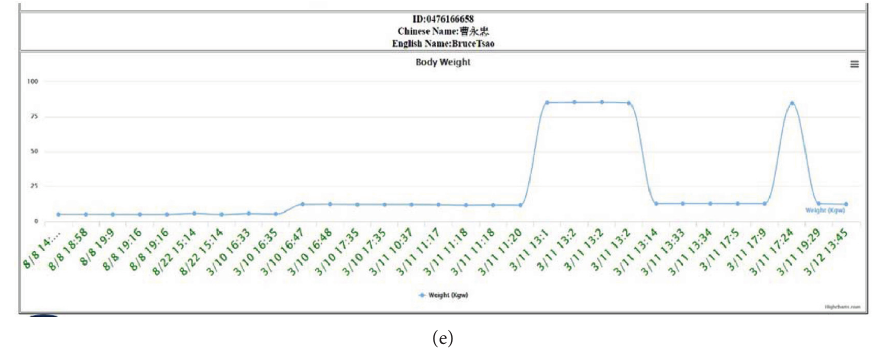
Figure 6: Detailed data displayed after clicking on the icon are shown in Figure 5 and presented as charts. These detailed charts are generated from the cloud platform provided by the SHMS. (a) shows the blood pressure results, including the blood pressure itself (systolic blood pressure and diastolic blood pressure) and the heart rate (maximum of 120 records), produced by our blood pressure device. Clients can learn the circulation status of the whole body, whether their blood pressure status is good or poor, and when hypertension occurs. (b) shows the blood oxygen results, including the blood oxygen level and heart rate (maximum of 120 records), obtained with the blood oxygen device. These results help clients understand the final blood circulation status and the circulation status of the whole body, which indicates whether their blood circulation is good or poor. (c) shows the head temperature results from thermal temperature scans (maximum of 120 records), which can be employed to detect and record body temperature in a contactless way. (d) shows the body temperature results from the elbow (maximum of 120 records) produced by our body temperature device. This device can continue to detect and record body temperature at intervals of a few seconds; thus, it can be applied in unhealthy conditions and can provide data that can be displayed in a long-term continuous temperature chart for the same interval. (e) shows the user weight results (maximum of 120 records) produced by our body weight device, and clients can determine whether they need to improve their health based on, e.g., their BMI. The measured body weight can also indicate blood pressure changes when the body weight changes over a long